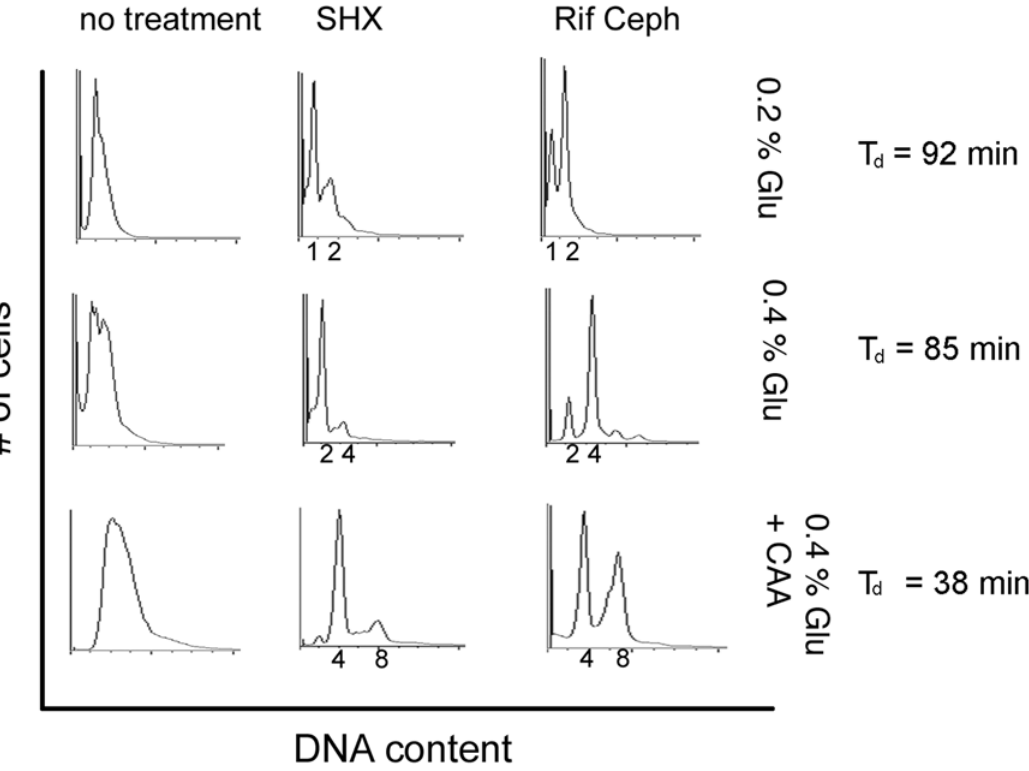
Figure 1. Flow cytometric analysis of cell cycle and effects of the stringent response. Cells were grown in 0.2% glucose, 0.4% glucose, or 0.4% glucose 0.2% casamino acids—M9 minimal media. DNA content for wild type and mutant cells before treatment (left panel), treated with serine hydroxamate (SHX) for 1.5 h (middle panel), or rifampicin or cephalexin for 4 h (right panel). Samples were taken for determination of DNA content by PicoGreen fluorescence (see Materials and Methods). The fluorescent scale (x-axis) corresponds to chromosome equivalents as indicated. The population doubling times, T d , for each growth condition are indicated.